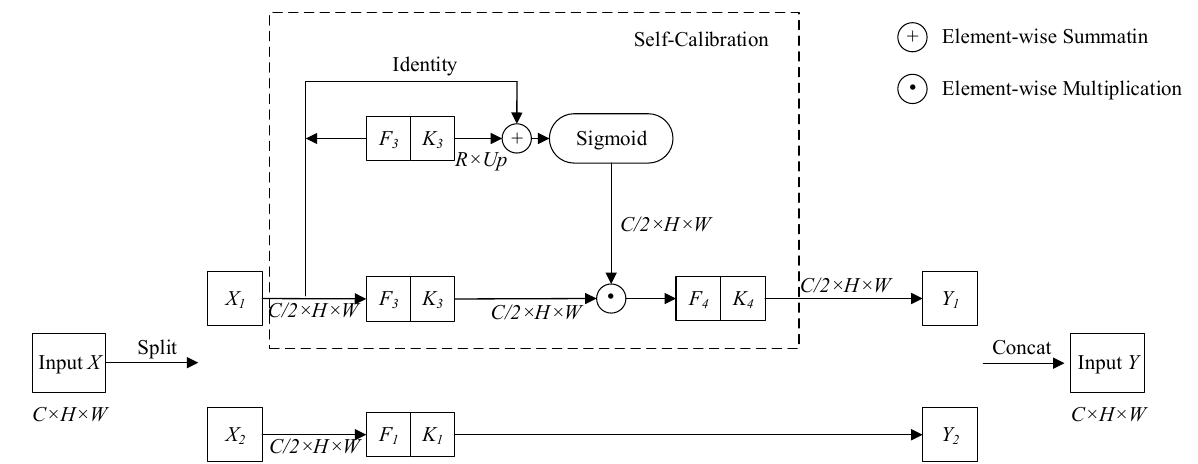
Figure 3. The schematic diagram of the self-calibrated Conv module. In self-calibrated convolutions, the original filters were separated into four portions, each in charge of different functionality. This makes self-calibrated convolutions quite different from traditional convolutions or grouped convolutions performed homogeneously.